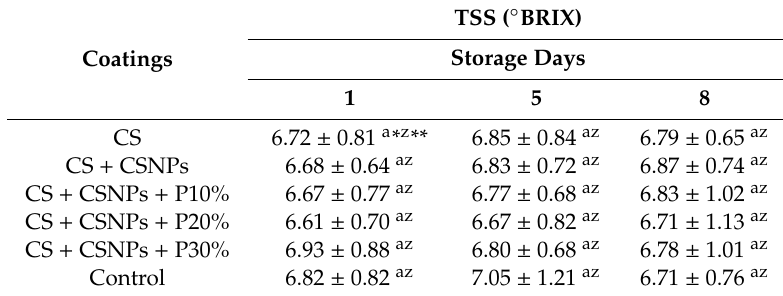
Table 3. TSS content of strawberry fruit treated with nanostructured chitosan and propolis extract coatings during eight days of